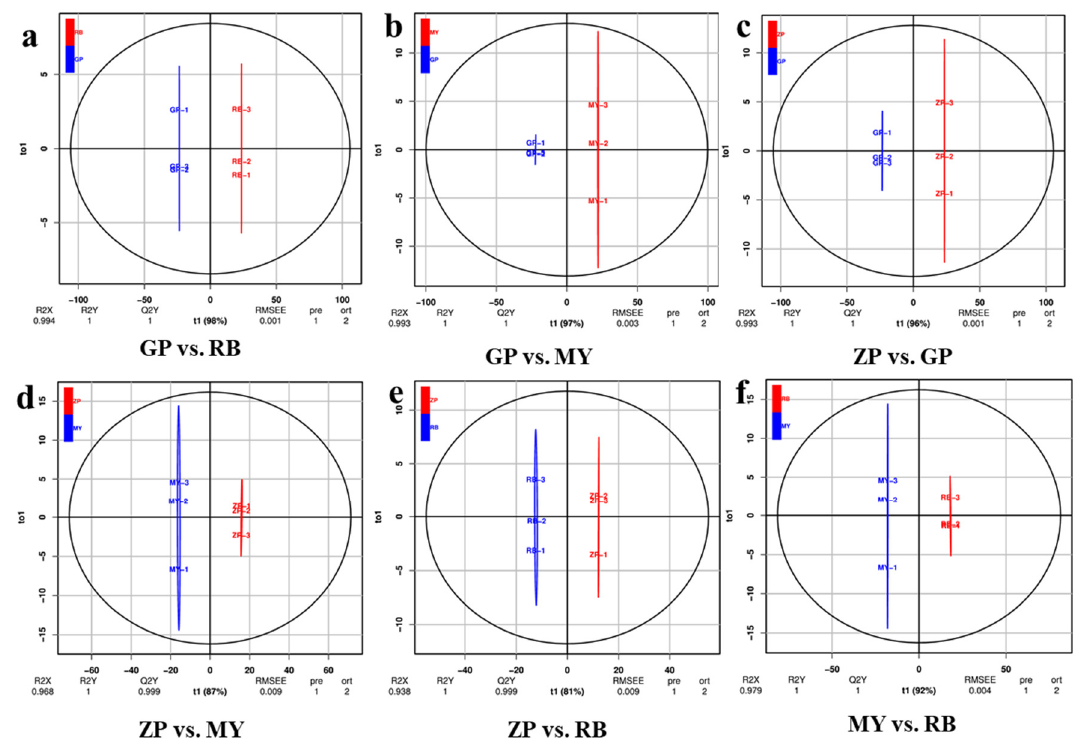
Figure 4. Di ff erential flavonoid metabolite analysis on the basis of OPLS-DA. ( a – f ) OPLS-DA model plots for the comparison groups GP and RB, GP and MY, ZP and GP, ZP and MY, ZP and RB, MY and RB. The t1 (abscissa) represents the predicted scores of PC1, and to1 (ordinate) represents the scores of the orthogonal principal components.